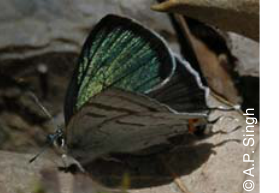
Image 45. Straightline Royal, Tajuria diaeus Male (under)